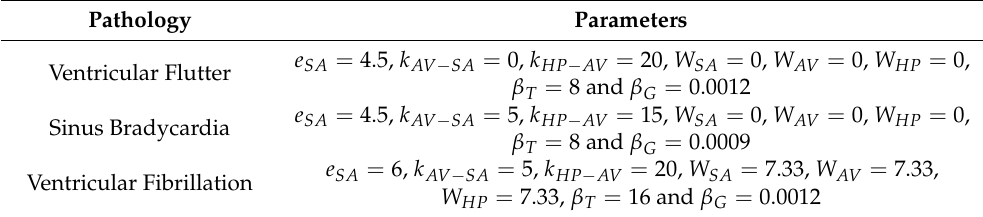
Table 3. Parameter values for the ring of three-coupled oscillators.